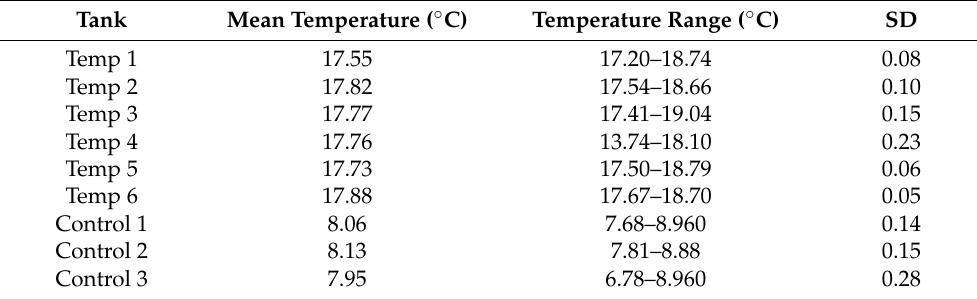
Table 2. Tank temperature readings from temperature loggers recording once per minute for adult common sea stars ( Asterias rubens ) during exposures to increased temperature (“Temp”, n = 6) and those in control group (“Control”, n = 3). The target temperature for the temperature group was 18 ◦ C, a 10 ◦ C increase over the control group maintained at 8 ◦ C.